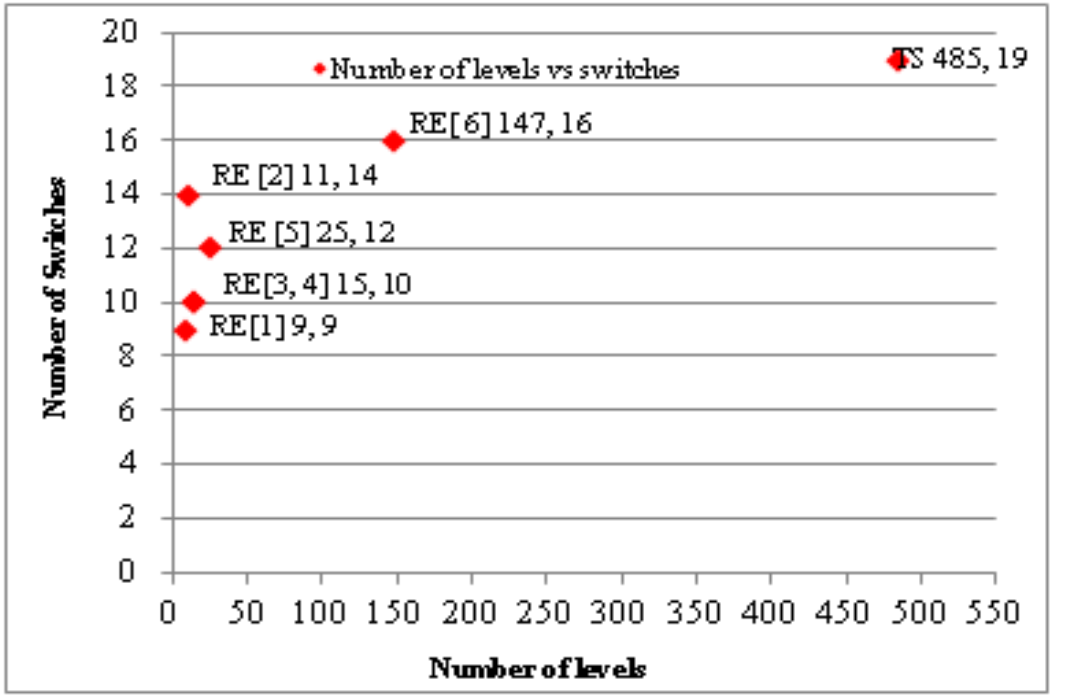
Figure 7. Sketch between the number of output levels and switches.